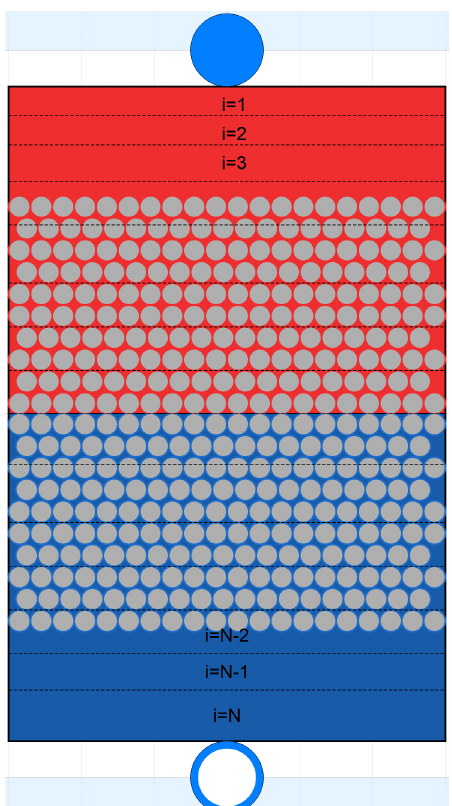
Figure 3. Nodal representation of the Modelica thermocline model (i = 1 corresponds to the top of the tank and what is readily deemed the “hot-side”, i = N is the bottom of the tank and is deemed the “cold-side”). Interaction is only between the nodes directly above and below a given node.